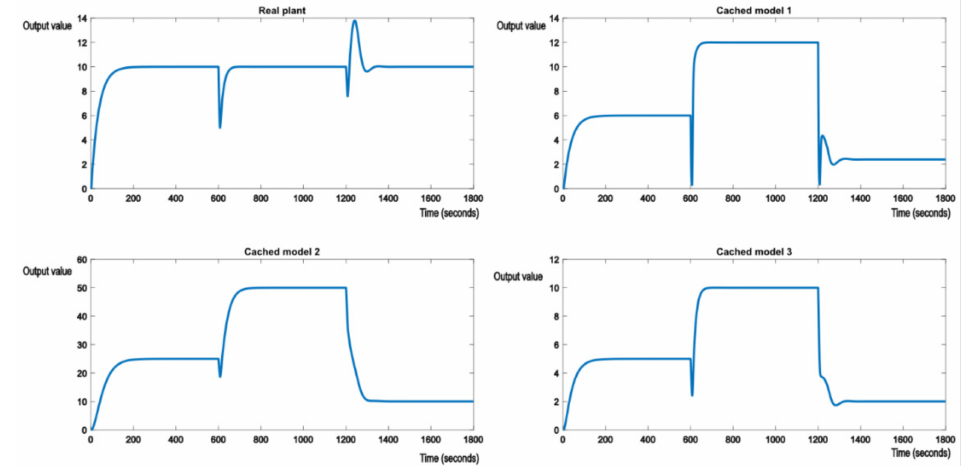
Figure 8. Evolution of the real plant and the nominal models after exposing the real plant to perturbations, switching from model 3 to model